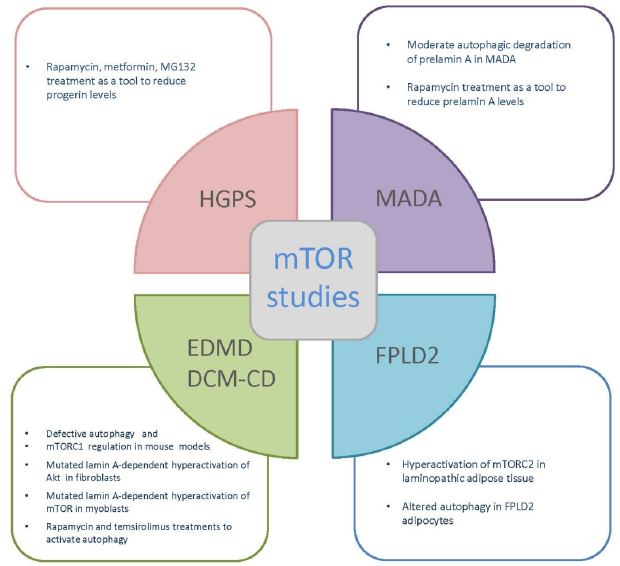
Figure 4. mTOR studies in laminopathies. Schematic representation of mTOR studies in EDMD, HGPS, MADA, and FPLD2. For EDMD see refs: [97,112]; for HGPS see refs: [120]; for MADA see refs: [5]; for FPLD2 see refs: [121] (Pellegrini et al., in